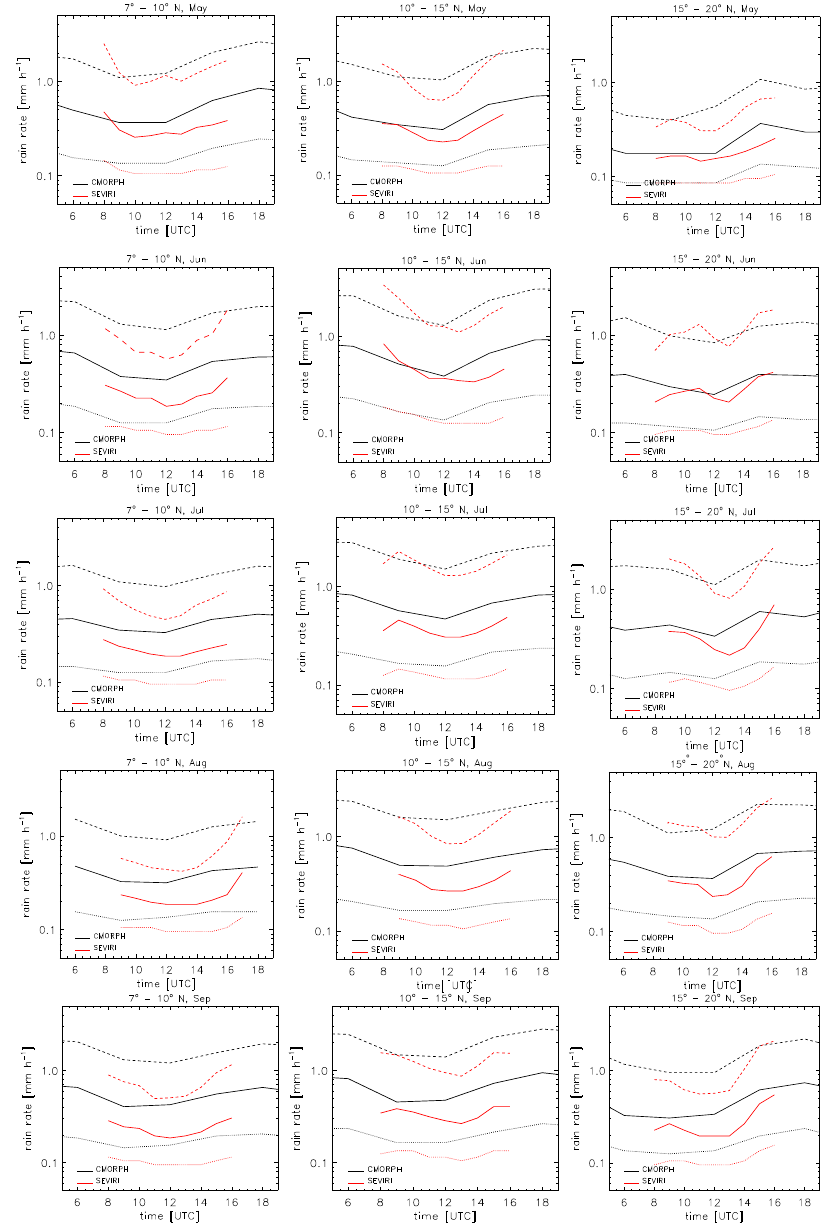
Fig. 9. (Black) CMORPH and (red) CPP-PP daytime cycle of rain rate (for values with R > 0.05mmh − 1 ) from May–September (average of 2005 and 2006) for (left column) 7 ◦ –10 ◦ N, (middle column) 10 ◦ –15 ◦ N, and (right column) 15 ◦ –20 ◦ N. Values were averaged over 10 ◦ W–10 ◦ E, CPP-PP rain retrievals have been collected in hourly bins. The 25th (dotted), 50th (solid), and 75th (dashed) percentiles are shown.